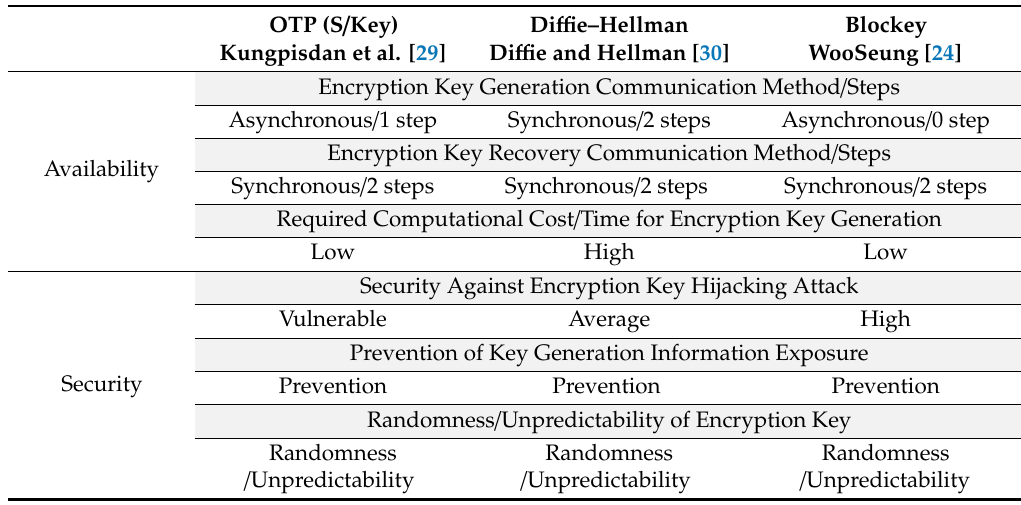
Table 1. Comparison table of related work.